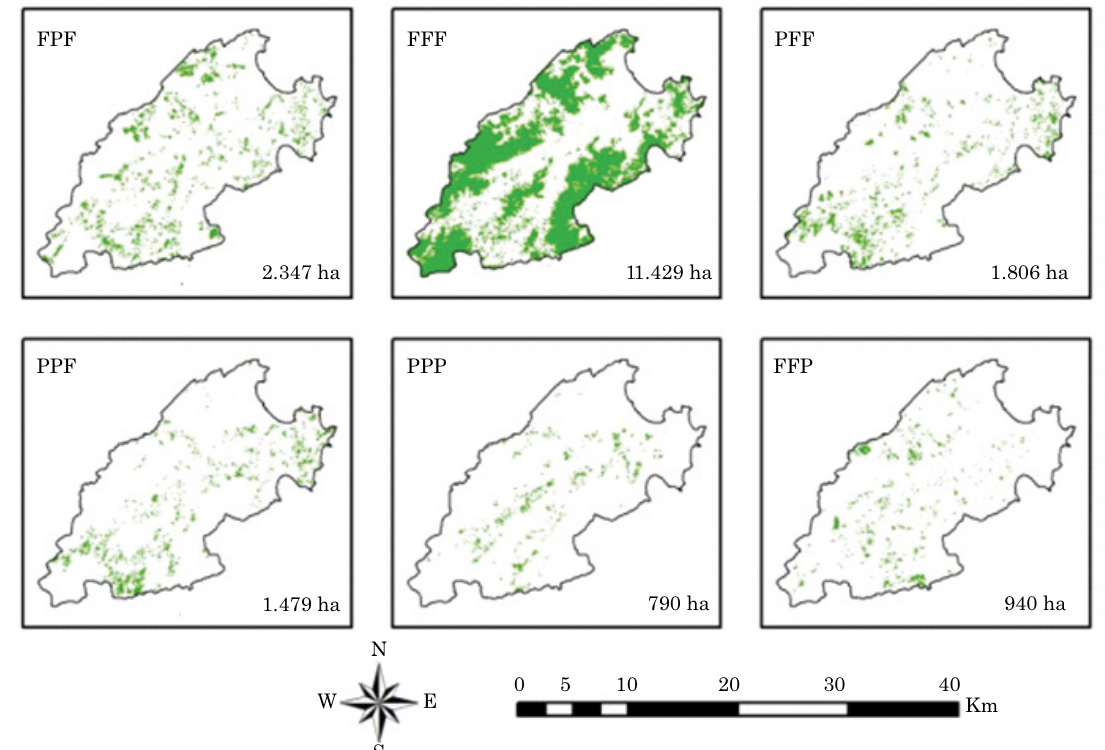
Figura 2. Mapas representando a localização das combinações de uso das terras mais representativas, com áreas (ha), nos municípios de Camboriú e Balneário Camboriú, em que FFF: uso com floresta a mais de 70 anos; FPF: área ocupada nos últimos 25 anos por floresta, antecedida por um período de 25 anos por pastagem e anteriormente por floresta; PFF: uso com florestas nos últimos 50 anos e pastagem no período anterior a 1957; PPF: área ocupada nos últimos 25 anos com floresta, antecedida por pastagem; PPP: uso com pastagem a mais de 70 anos; e FFP: uso com pastagem nos últimos 25